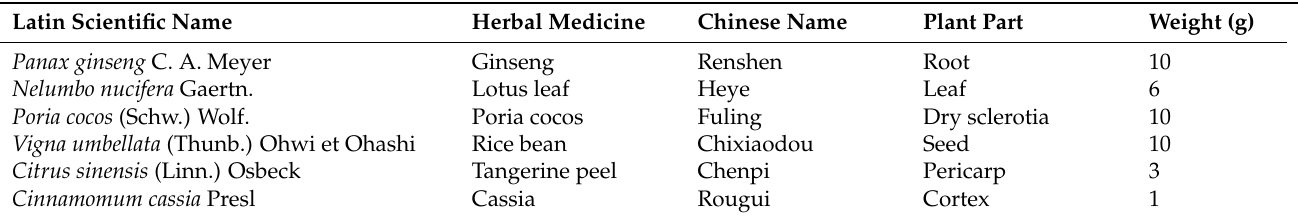
Table 1. The composition and proportions of SHL.